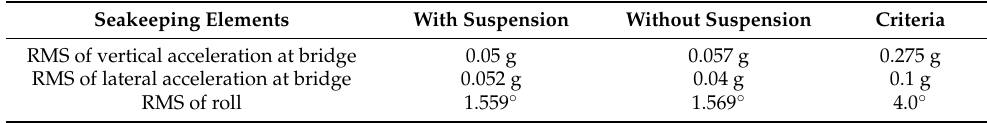
Table 6. Seakeeping criteria values with moderate waves.